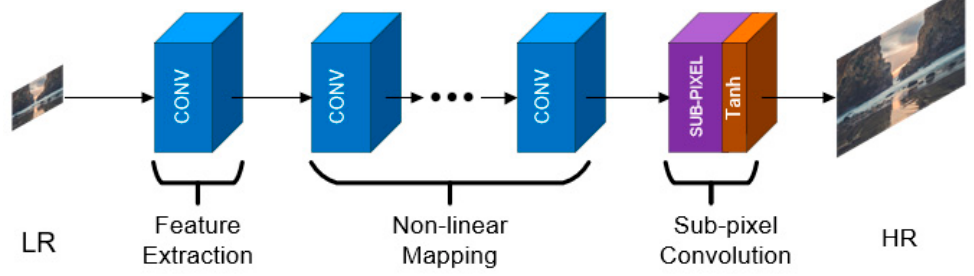
Figure 4. ESPCN network structure.